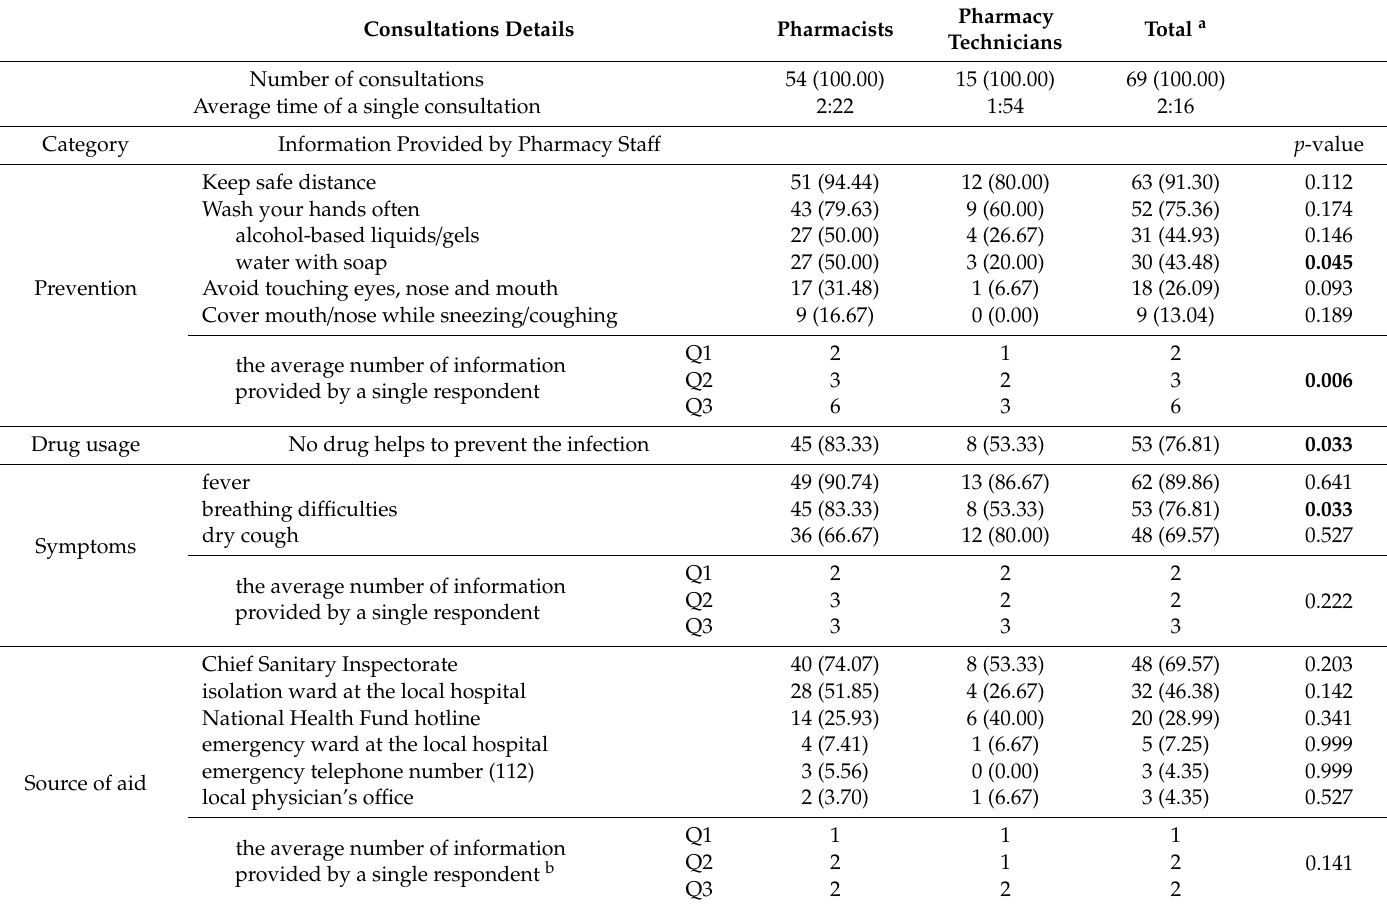
Table 2. Recommendations for patients provided by pharmacists and pharmacy